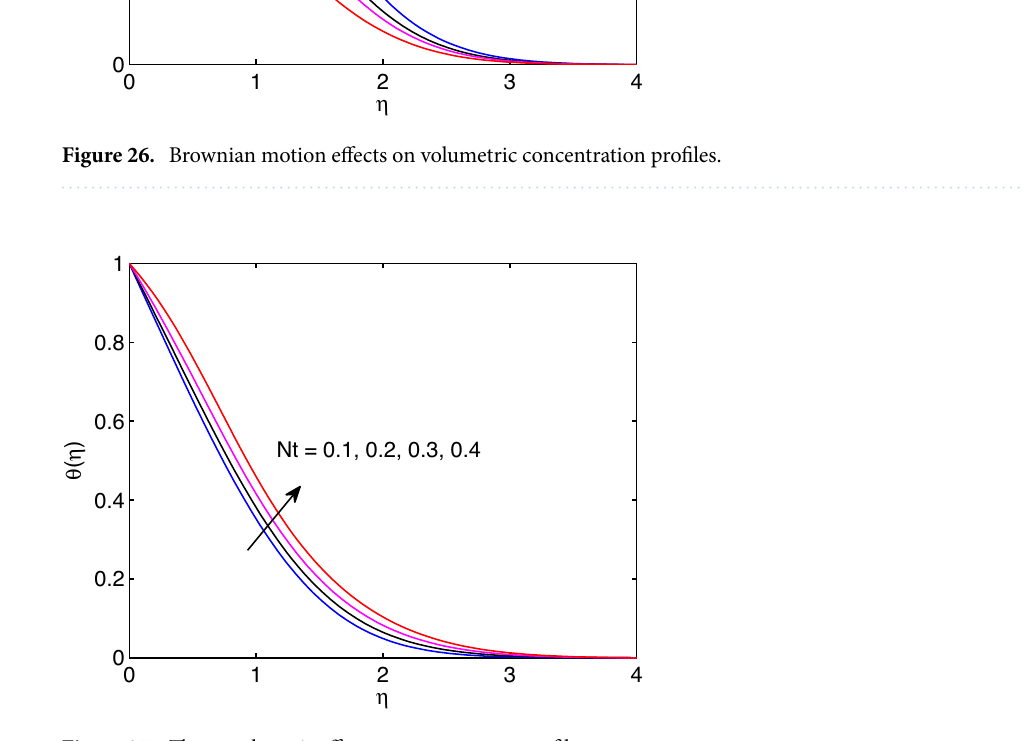
Figure 27. Thermophoresis effects on temperature